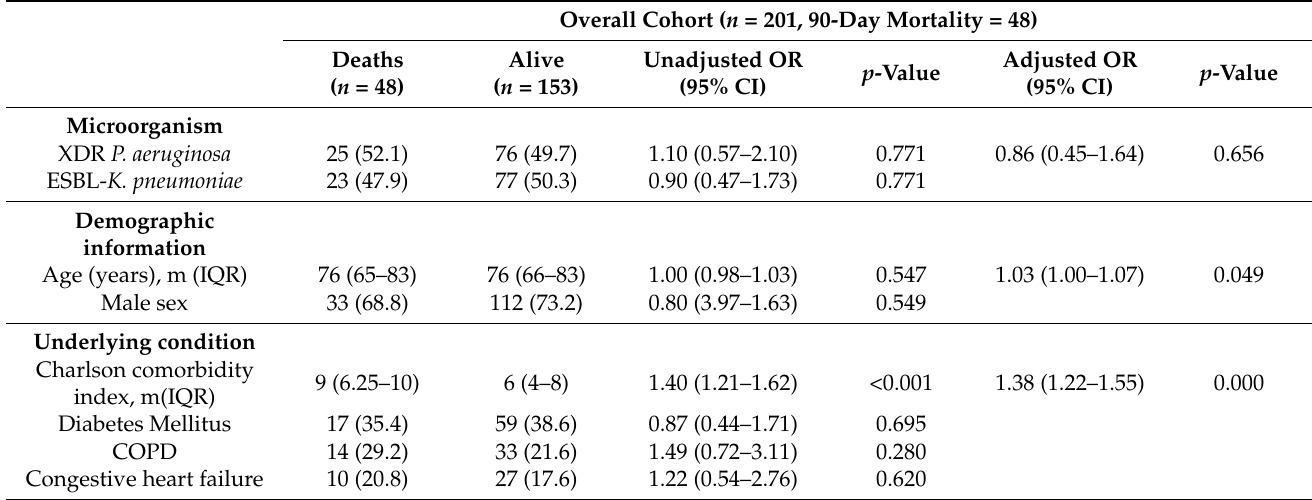
Table 5. Univariate and multivariate analysis of parameters predicting 90-day